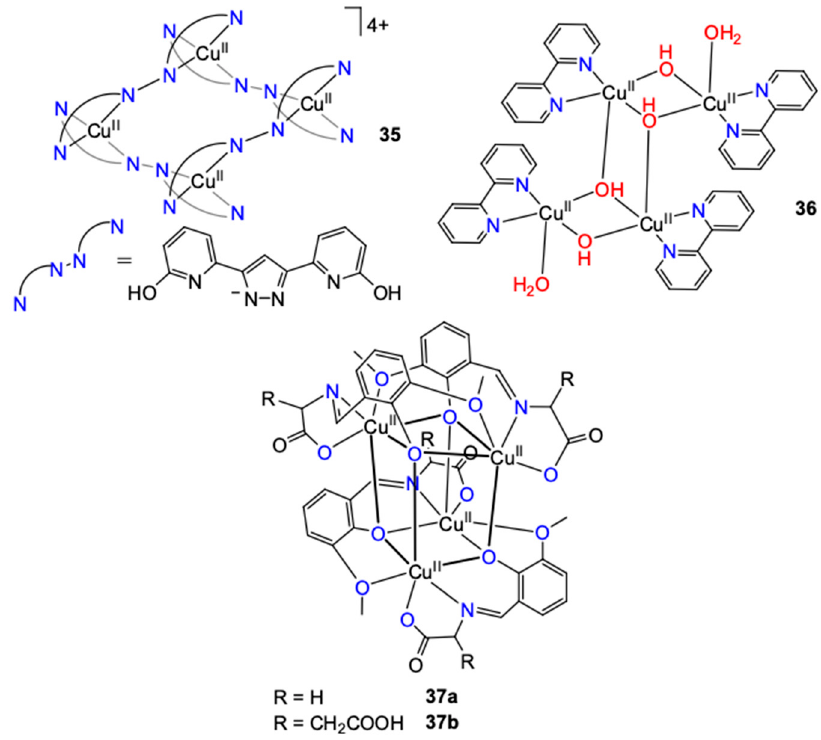
Figure 22. Multi-copper catalysts. Table 4. Kinetic, electrochemical data and reaction conditions of multi-copper water oxidation catalysts. Catalyst pH Electrolyte k obs (s − 1